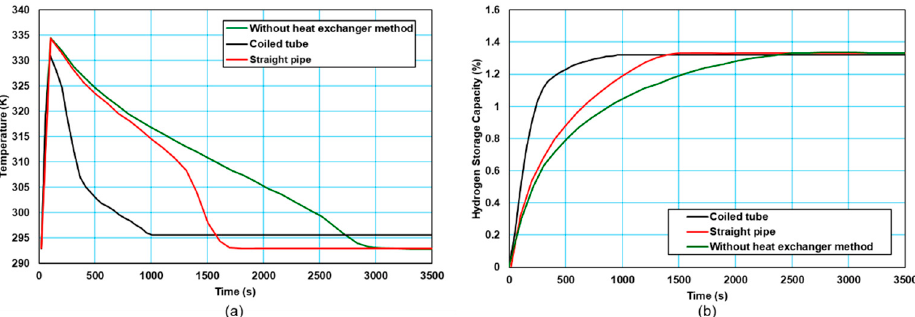
Figure 4. The effect of active thermal management methods on ( a ) tank temperature, ( b ) effect on hydrogen storage capacity (Data are taken from [21]).